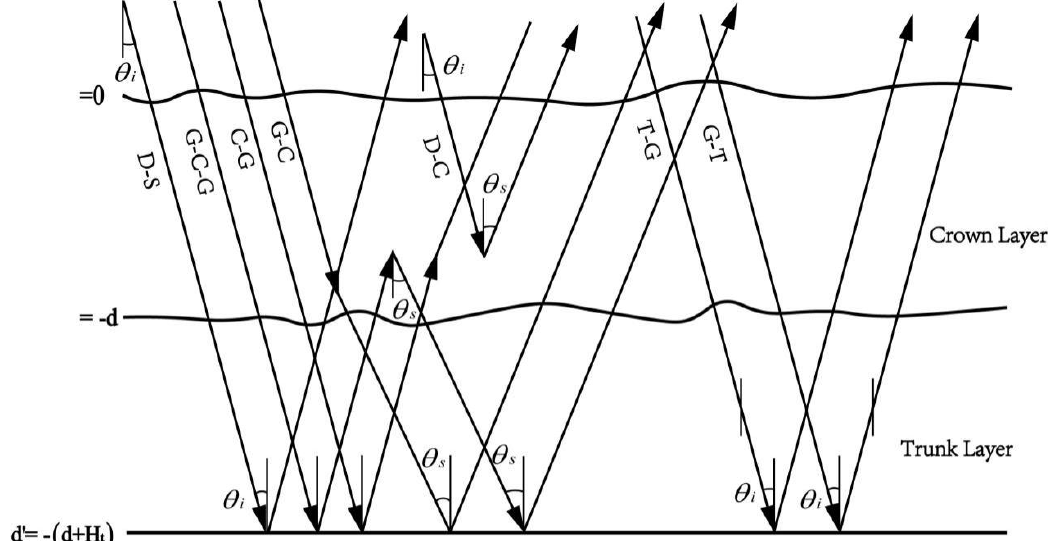
Figure 1. Scattering mechanisms in the first-order Bi-MIMICS model, including G-C-G (ground reflection and crown scattering and ground reflection), C-G (crown scattering and ground reflection), DC (direct crown bistatic scattering), G-C (ground reflection and crown scattering), G-T (ground reflection and trunk scattering), DG (direct ground), and T-G (trunk scattering and ground reflection). The specular ground reflection is not shown in the figure. Crown layer depth = d, trunk layer depth = H.